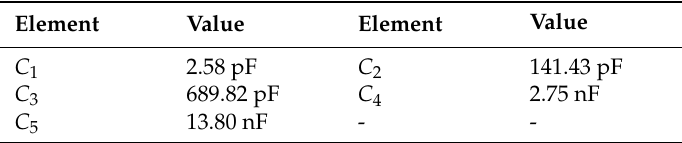
Figure 7. Realization of fractional-order capacitor emulator (Inverse Follow-the-Leader Feedback (IFLF) methodology). Table 8. Values of the capacitors of Figure 7.